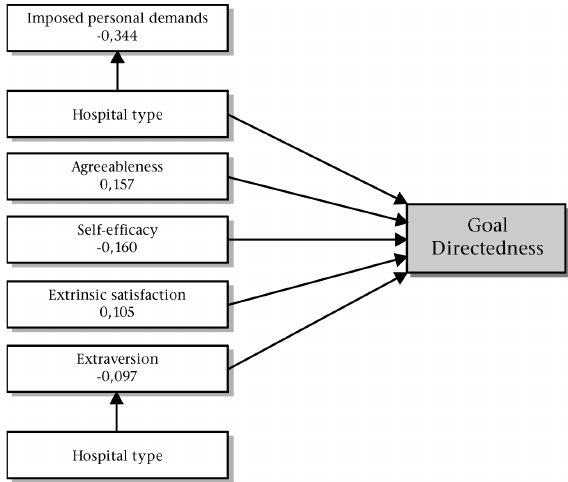
Figure 7: Biographical variables, job satisfaction and